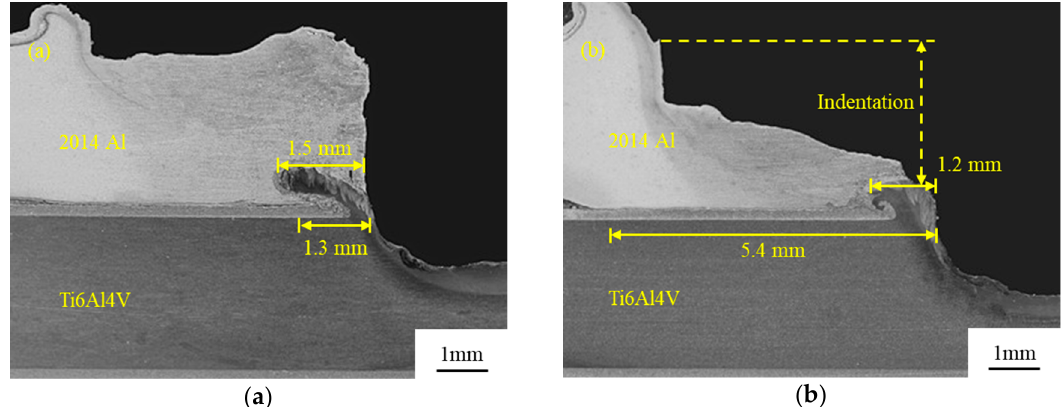
Figure 11. Microstructure of the stir zone of the FSSW-B joint made at the tool rotation speed of ( a ) 900 rpm and ( b ) 1500 rpm. The labeled dimensions were measured via the optical microscope measurement.